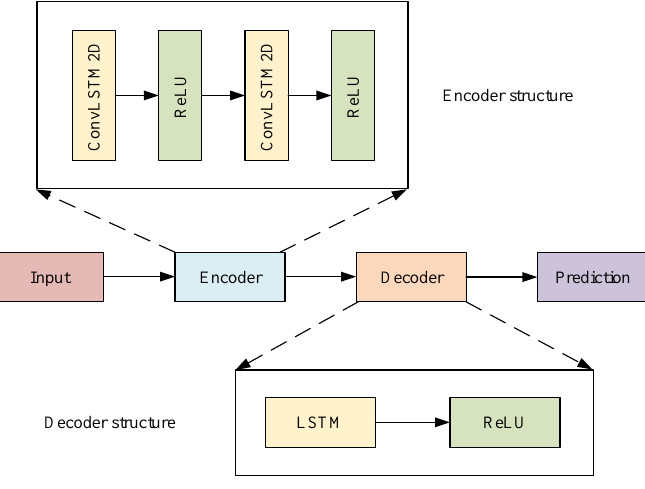
Figure 1. An overview of the ConvLSTM Encoder–Decoder network (ConvLSTM). Multivariate ALSTM Fully Convolutional Networks models are comprised of temporal convolutional blocks and an LSTM block, as depicted in Figure 2. The feature extractor consists of three stacked temporal convolutional blocks. In addition, the first two convolutional blocks conclude with a squeeze and excite block.